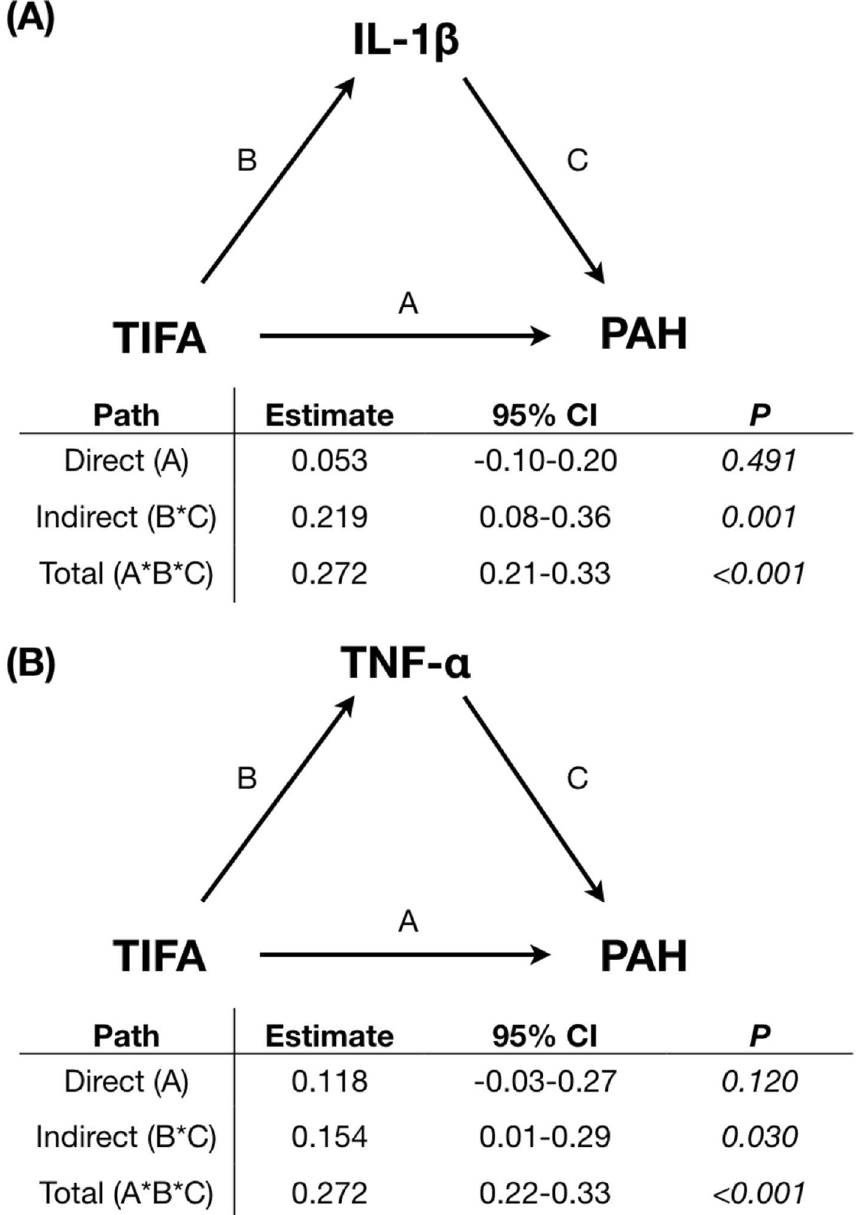
Figure 4. Causal-mediation relationship between TIFA, TNF-α and IL-1β in the pathogenesis of PAH. ( A ) IL-1β as mediator, ( B ) TNF-α as mediator. The effect estimates (hazard ratio) and 95% confidence intervals are reported for all paths (A: direct effect, B*C: indirect effect, A*B*C: total effect). Models were adjusted for age and gender. There were significant indirect and total effects between TIFA and PAH mediated by IL-1β or TNF-α, suggesting that upregulated TIFA protein expression contributes to the development of PAH via the activation of IL-1β (attributable proportion: 80.4%) and TNF-α (attributable proportion: